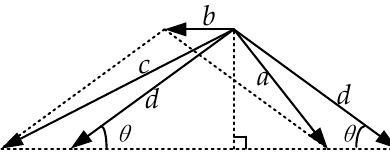
Figure 4. Influence analysis of the geomagnetic field.